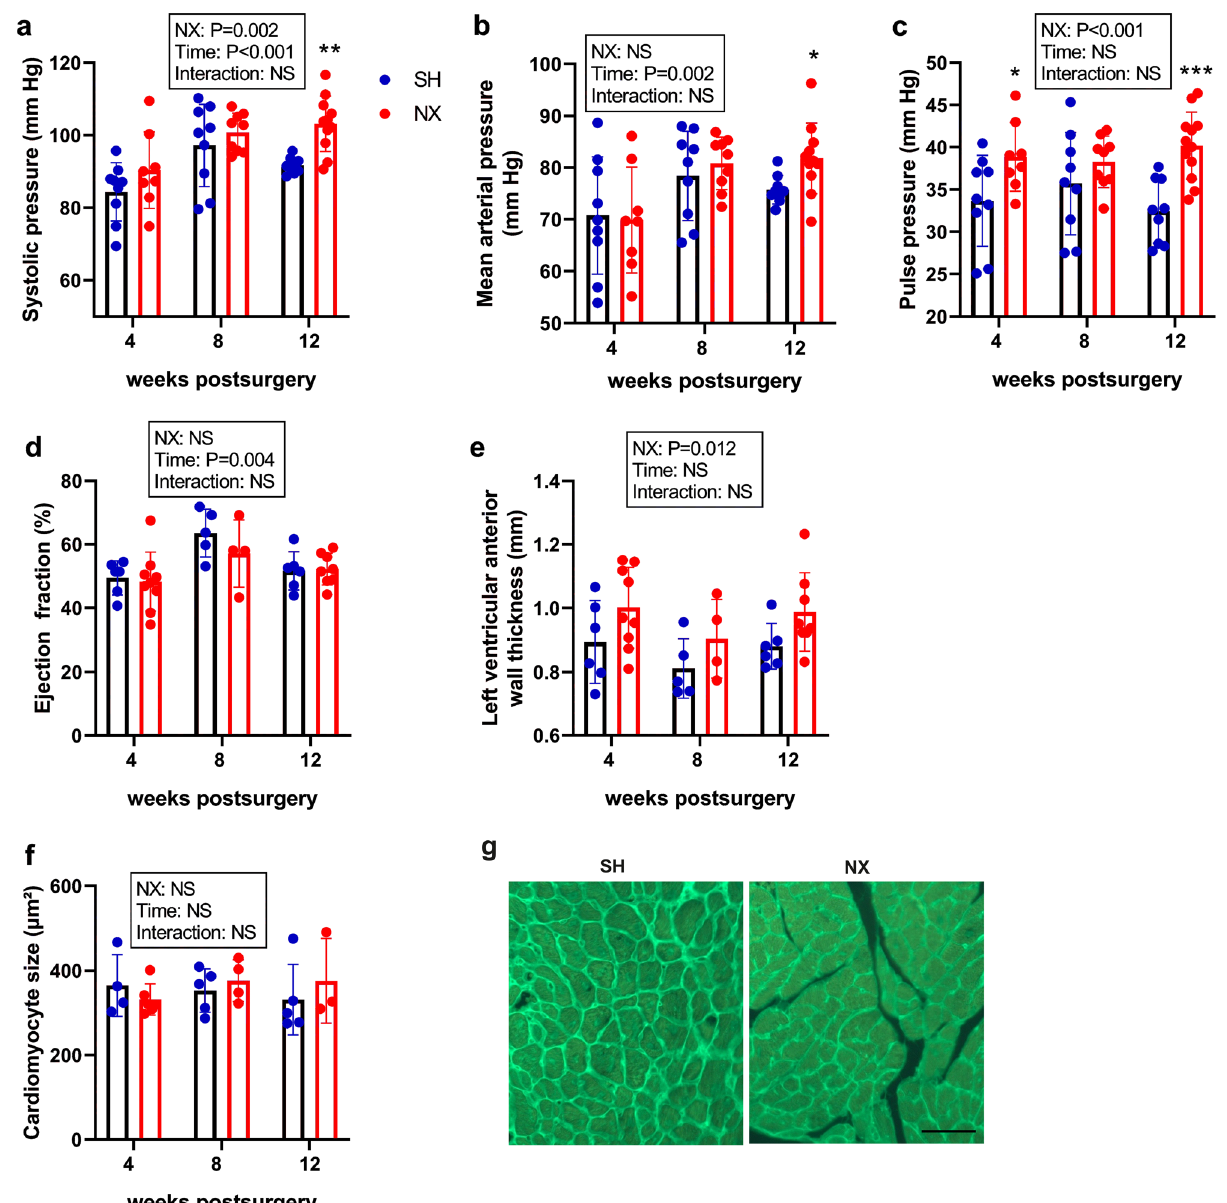
Figure 3. Mild hypertension but absence of left ventricular hypertrophy and dysfunction in 5/6-Nx mice on CPD. ( a ) Systolic, ( b ) mean arterial, and ( c ) pulse pressure measured by intraarterial catheterization, ( d ) ejection fraction and ( e ) left ventricular anterior wall thickness measured by echocardiography, and ( f ) cardiomyocyte size measured by ( g ) wheat germ agglutinin staining in Sham-operated (SH) and 5/6-Nx (NX) C57BL/6 mice on CPD, 4, 8 and 12 weeks postsurgery. N = 3–11 mice per group. Bars depict mean values ± SD. Data were analyzed using 2-way ANOVA, followed by Student’s t test. Insets show results of 2-way ANOVA. * P < 0.05; ** P < 0.01; *** P < 0.001 versus Sham at same time point by Student’s t test. Bar = 50 µm in ( g